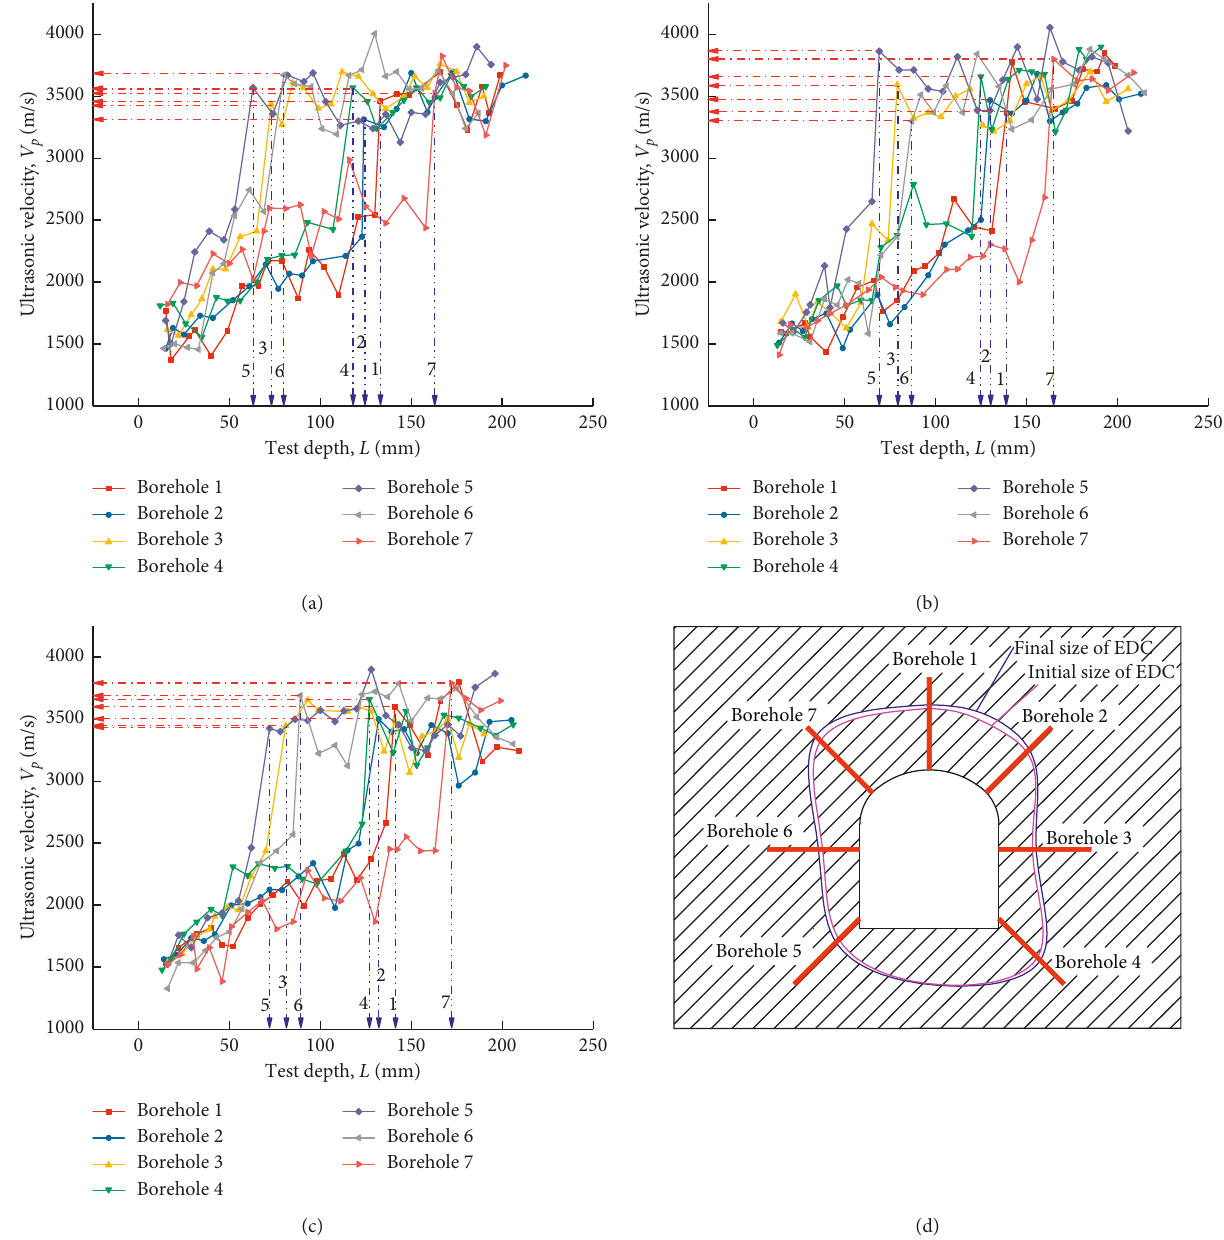
Figure 7: Relationship between V p and L of different dates in Section 3: (a) test results on March 26, (b) test results on April 3, (c) test results on April 11, and (d) initial size and final size of the